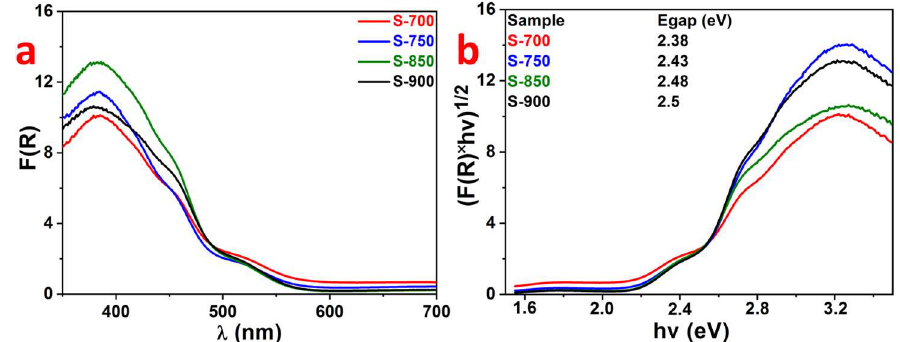
Figure 6. Kubelka-Munk diffuse reflectance UV-Vis spectra ( a ) and resulting band gaps from Tauc plots ( b ) of the studied LaFeO 3 samples.